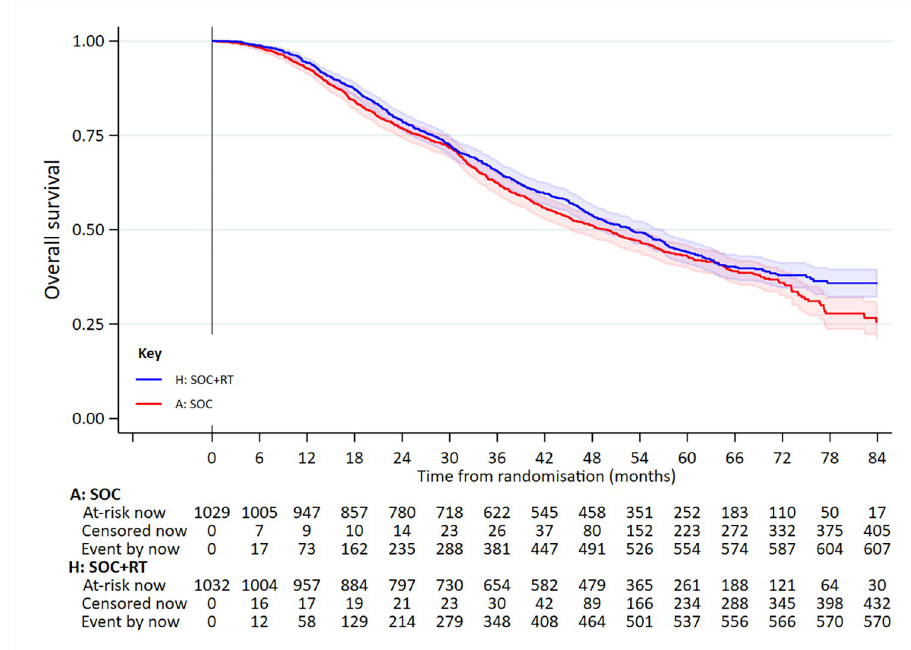
Fig 2. OS in all patients. Adjusted HR = 0.90 (95% CI 0.81 to 1.01; p = 0.081). HR, hazard ratio; OS, overall survival; RT, radiotherapy to the prostate; SOC, standard of